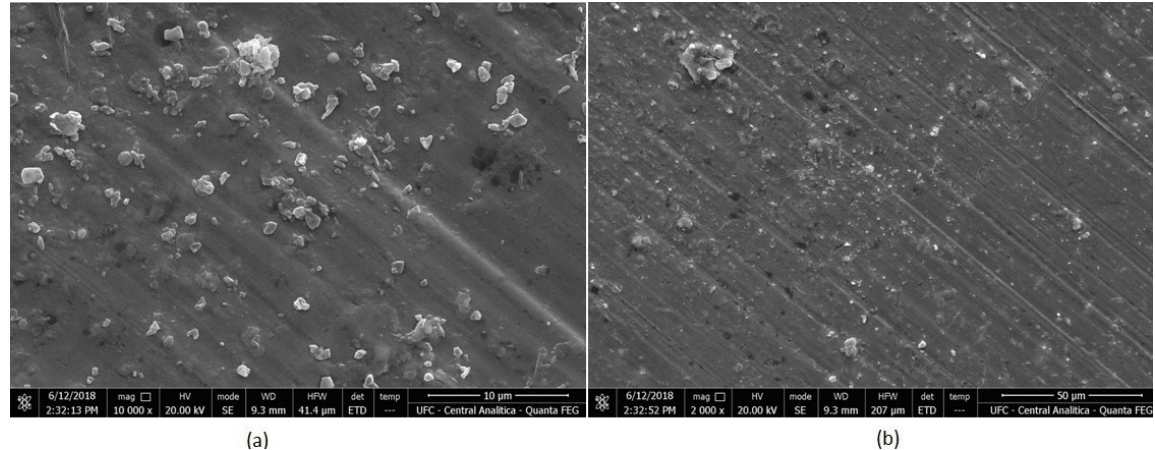
Figure 7: Micrograph of the MR TiNOX selective surface sample, with magnification factor of: (a) 10000x and (b)